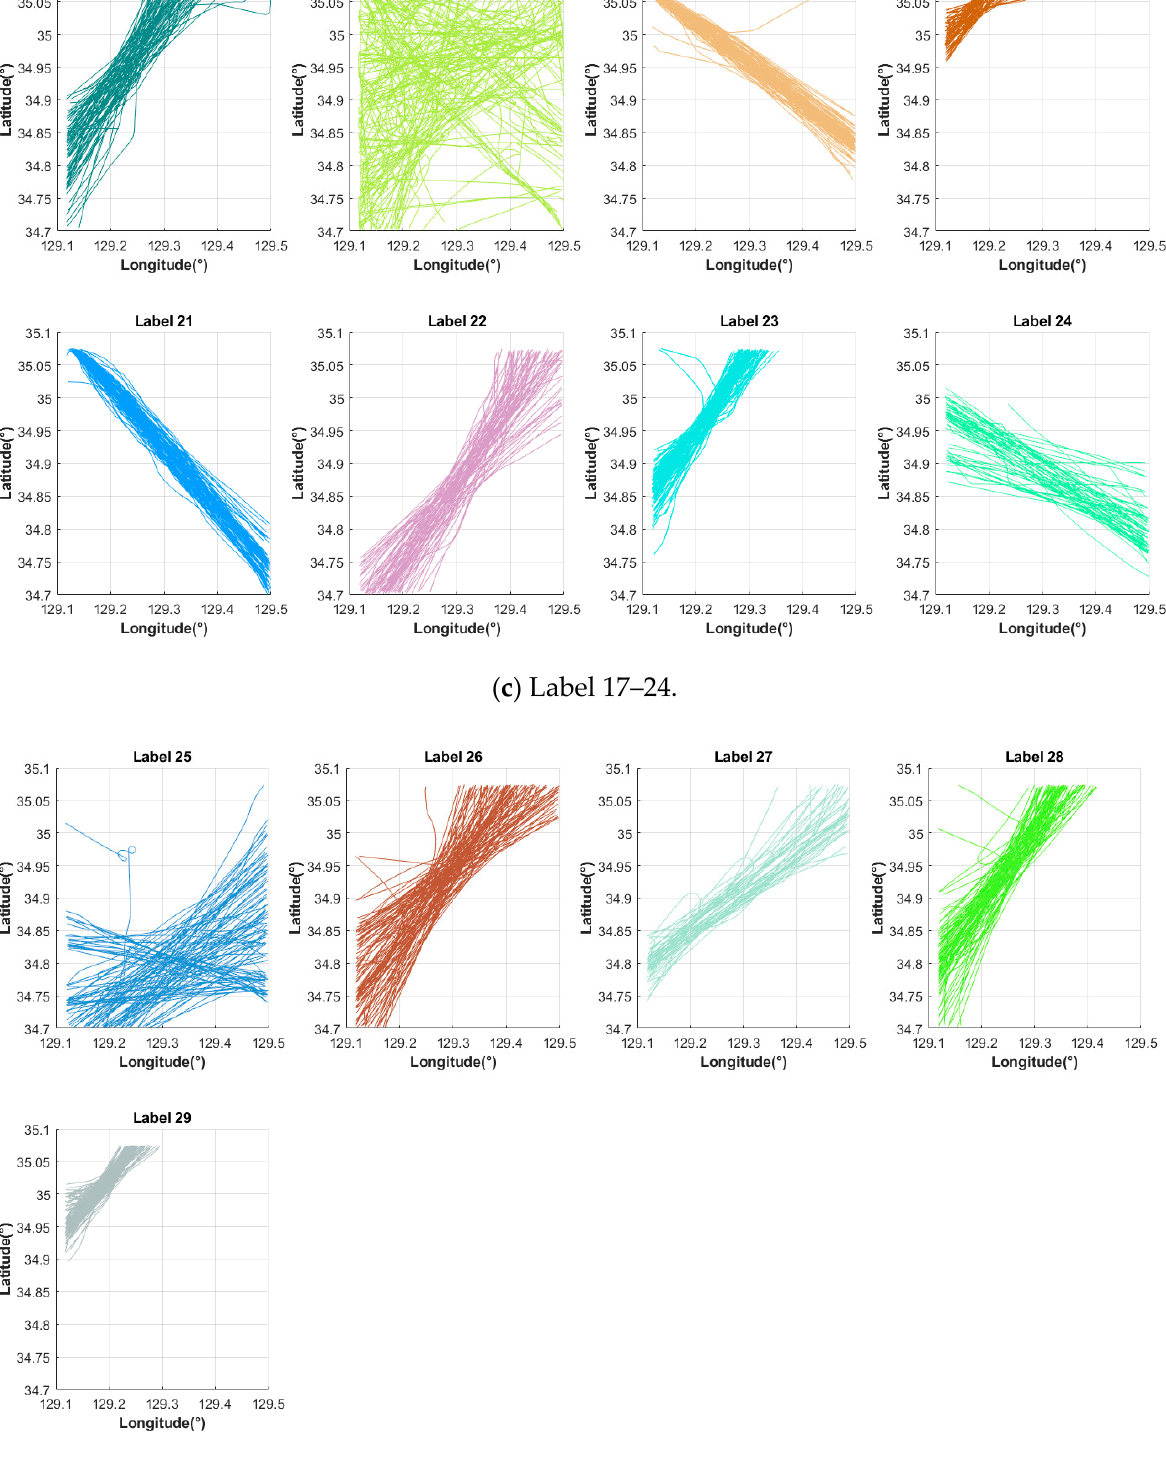
Figure 7. Ship trajectory plot of each cluster.